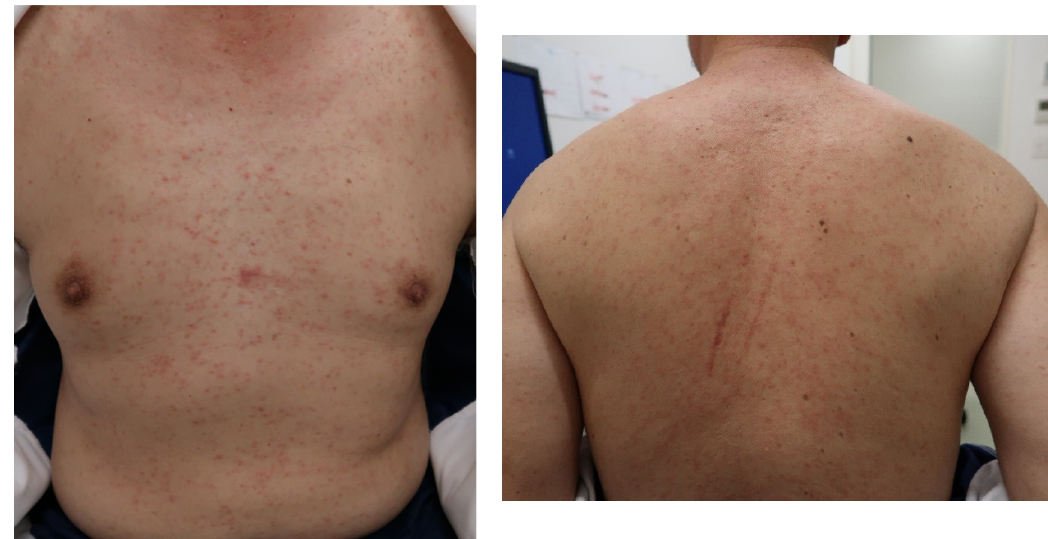
Figure 1. Pink papules throughout the body of the patient.